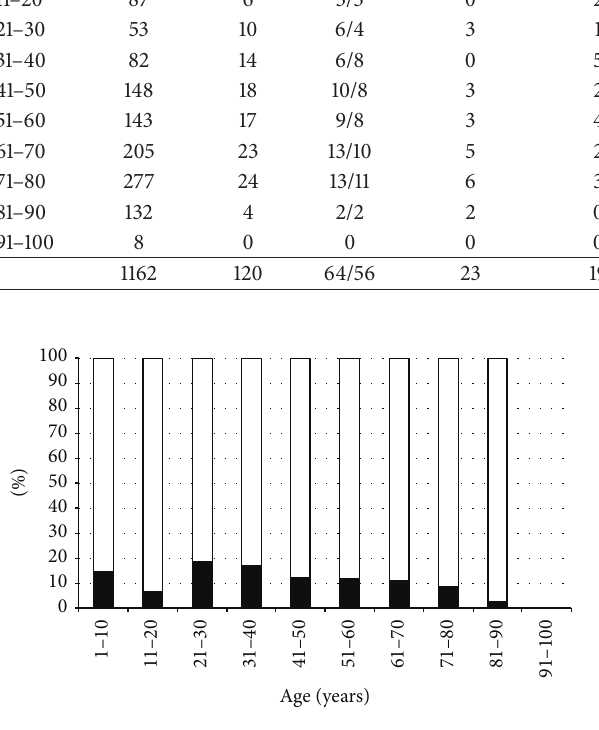
Figure 3: Percentage of overall and asymptomatic dry eye in OSD patients by age group. Black bars: overall dry eye; white bars: asymptomatic dry eye (OSDI ≤